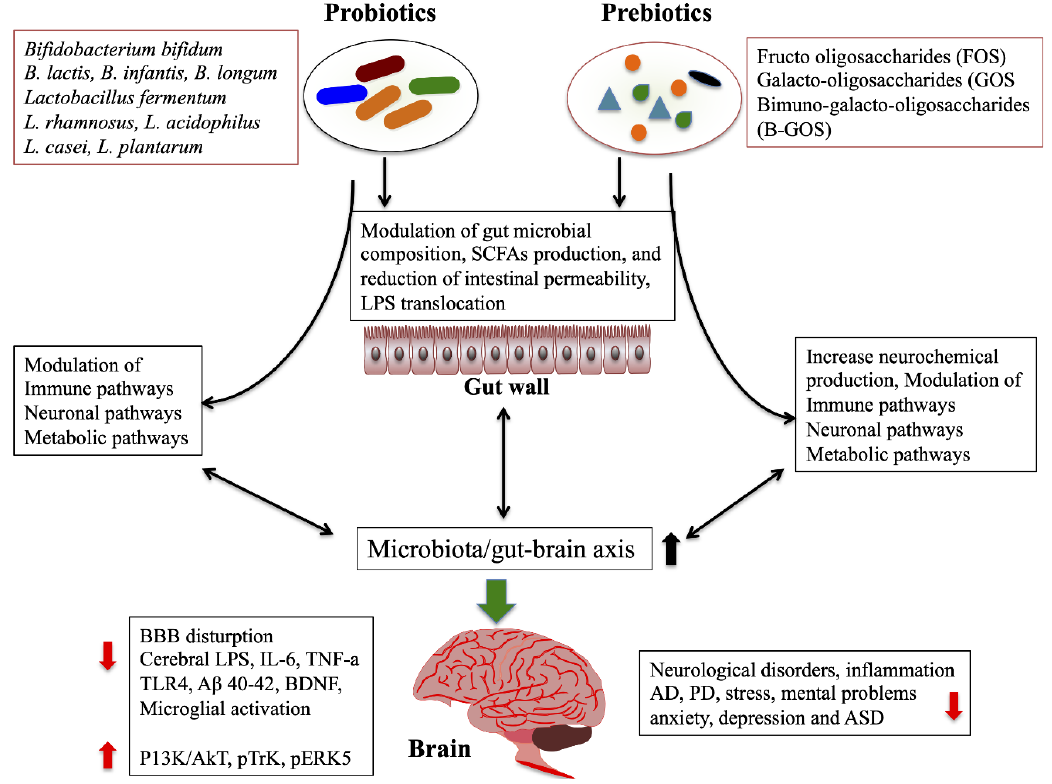
Figure 4. Effect of probiotics/prebiotics on improvement of microbiota/gut – brain axis. The presence of probiotics and prebiotics or combination of both was able to improve neurological complications by increasing the production of SCFAs and neurochemicals, reducing the intestinal permeability, and modulating the gut microbial composition, immune, metabolic, and neural pathways. ( ↑ ↓ indicate up and down-regulation).